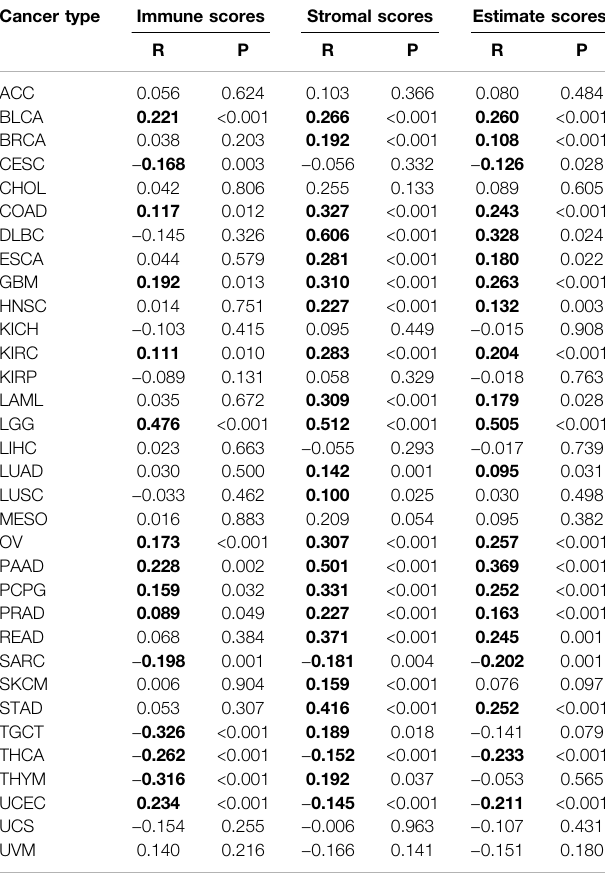
TABLE2| Correlationanalysisof PLOD2 expressionwithimmunescores,stromal scores, and estimate scores. Cancer type Immune scores Stromal scores